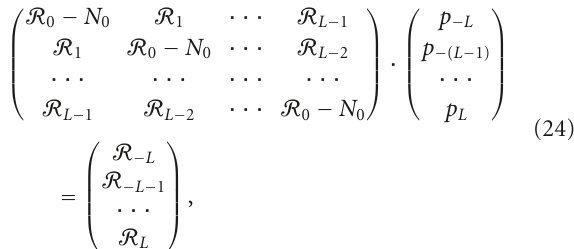
Figure 7: Distribution of u k = Re { y k y ∗ di ff erential detection (assume “+1”